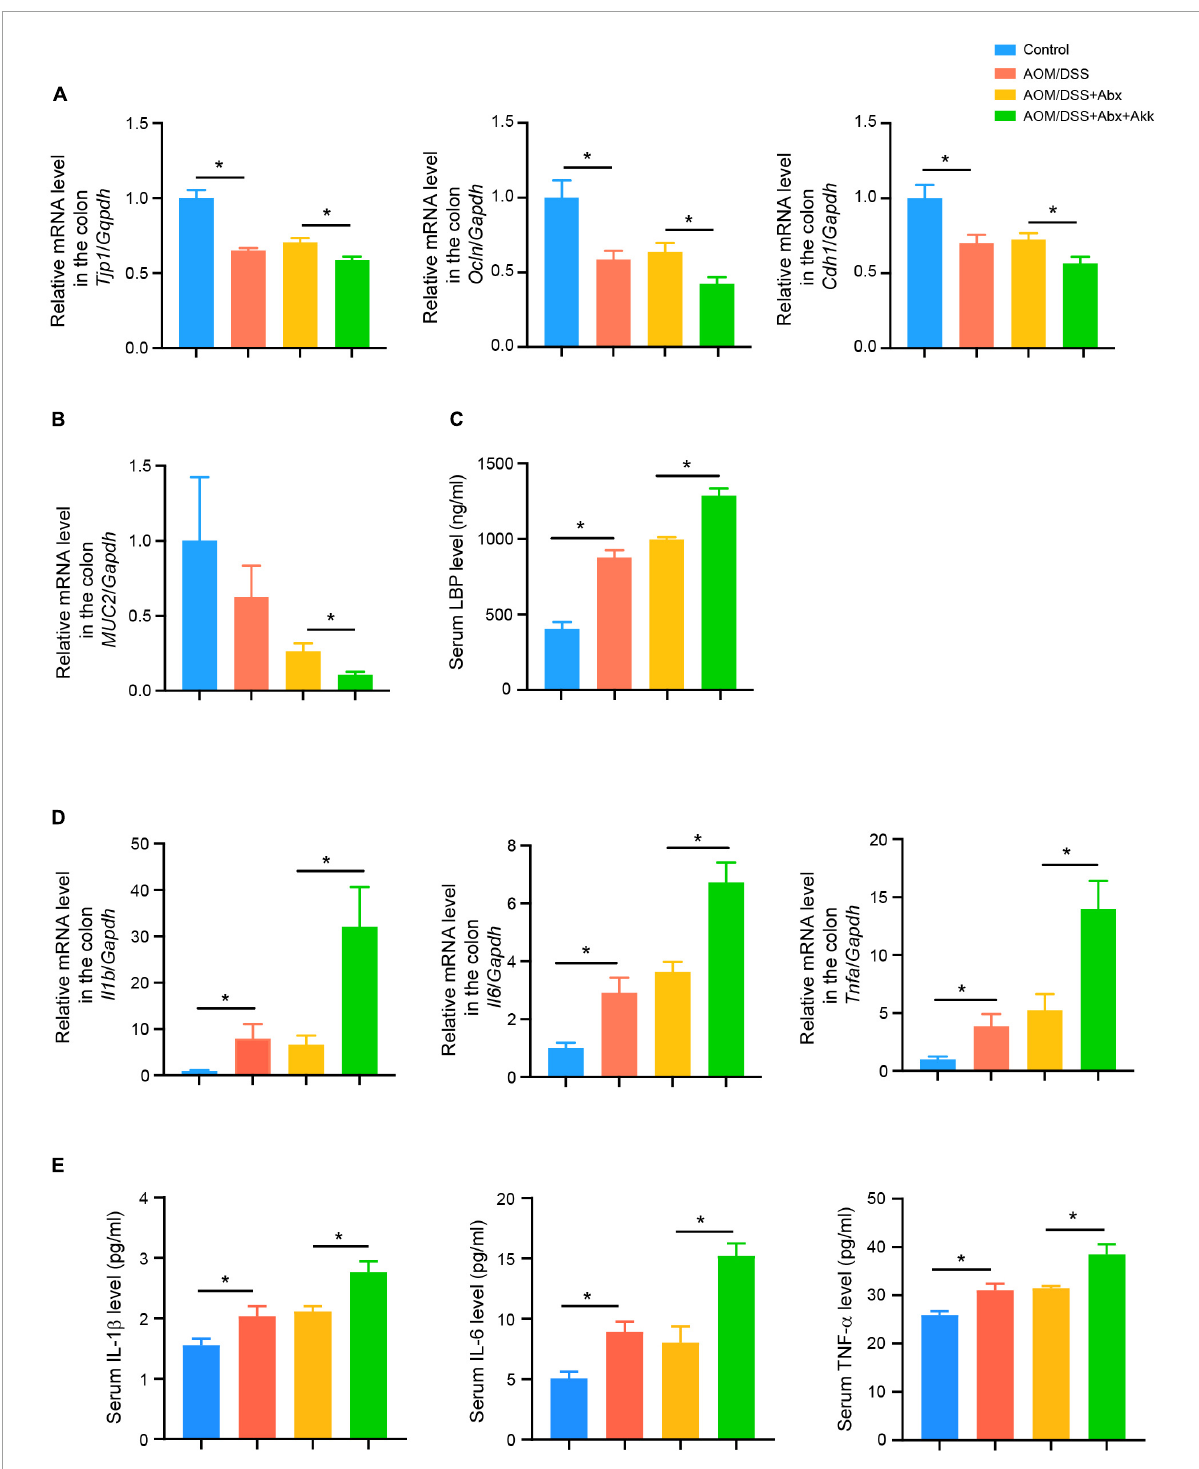
FIGURE3 Post-antibiotic supplementation with Akkermansia muciniphila worsened the gut barrier and aggravated colonic and systemic inflammation during tumorigenesis. (A) Colonic relative mRNA levels of Tjp1 , Ocln , and Cdh1 in the four groups. (B) Colonic relative mRNA expression level of MUC2 in the four groups. (C) Serum LBP level in the four groups. (D) Colonic relative mRNA expression levels of Il1b , Il6 , and Tnfa in the four groups. (E) Serum levels of IL-1 β , IL-6, and TNF- α in the four groups. Data are shown as means ± SEM. * P <